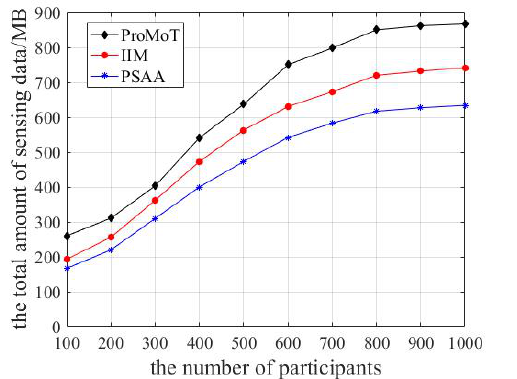
Figure 5. The total volume of sensing data.